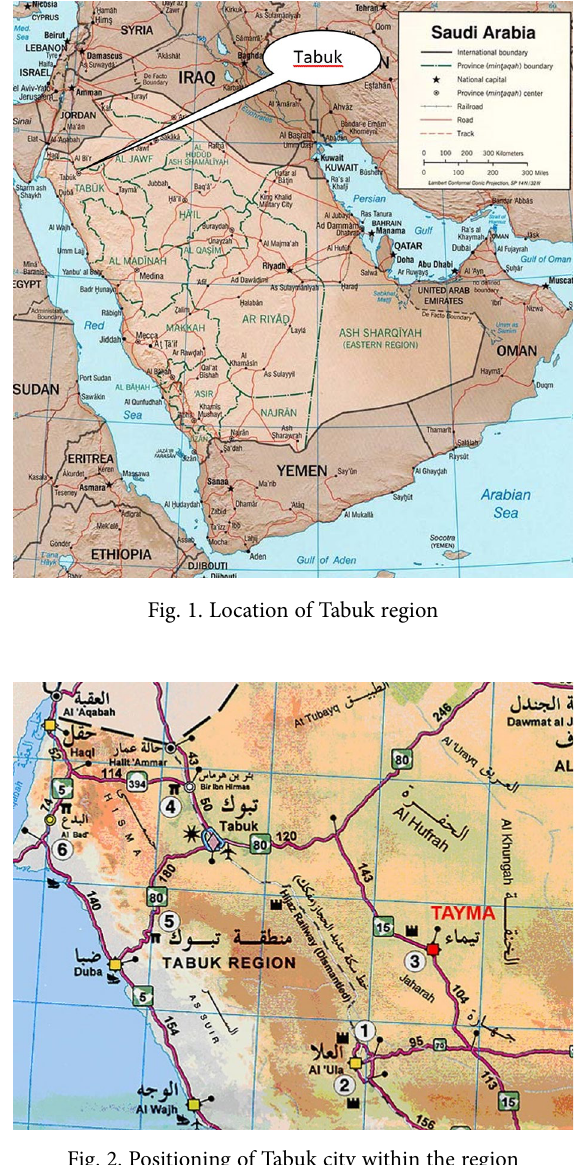
Fig. 2. Positioning of Tabuk city within the region